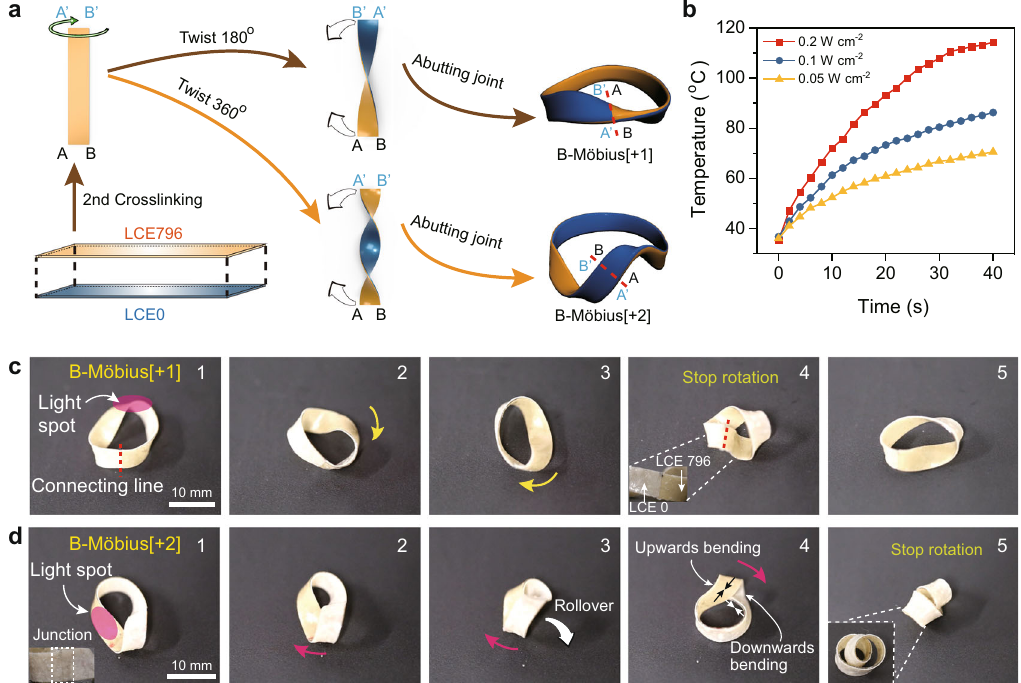
Fig. 3 Preparation procedure and actuation behaviour of bilayered actuators. a Schematic illustration of the fabrication procedures of B-Möbius[ + 1] and B-Möbius[ + 2] ribbon actuators. b Real-time surface temperature pro fi les of the bilayered LCE fi lm stimulated by NIR light of various intensities. Photographs showing the shape deformations of c B-Möbius[ + 1] and d B-Möbius[ + 2] ribbon actuators under the clockwise stimulation of NIR light irradiated on their locus of twist regions (scale bars: 10 mm). Supplementary Movie 2 shows the scenario in